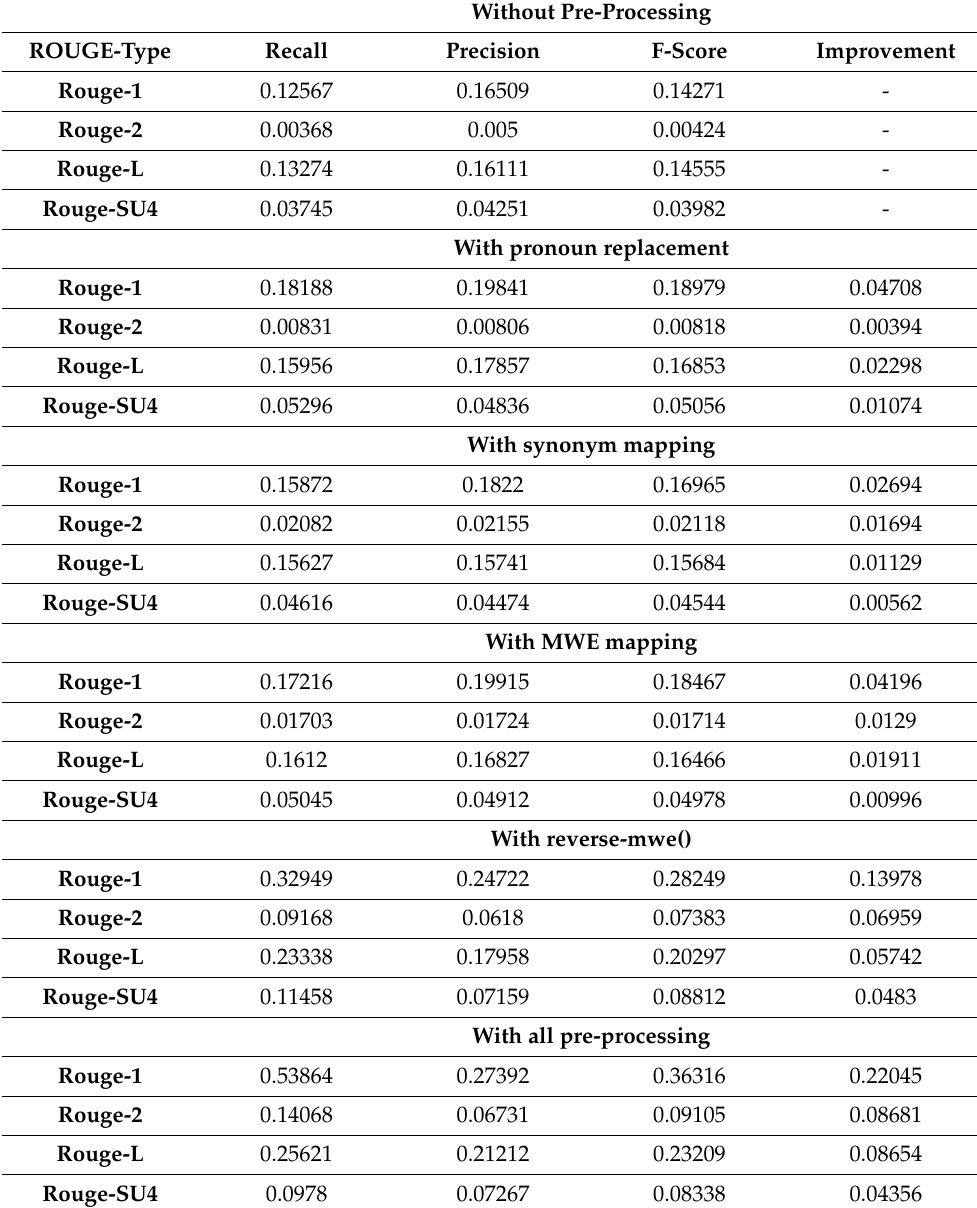
Table 2. Ablation study representing the effects of different pre-processing phases on